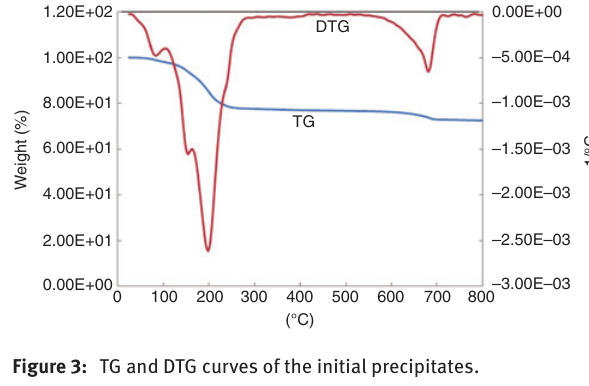
Figure 3: TG and DTG curves of the initial